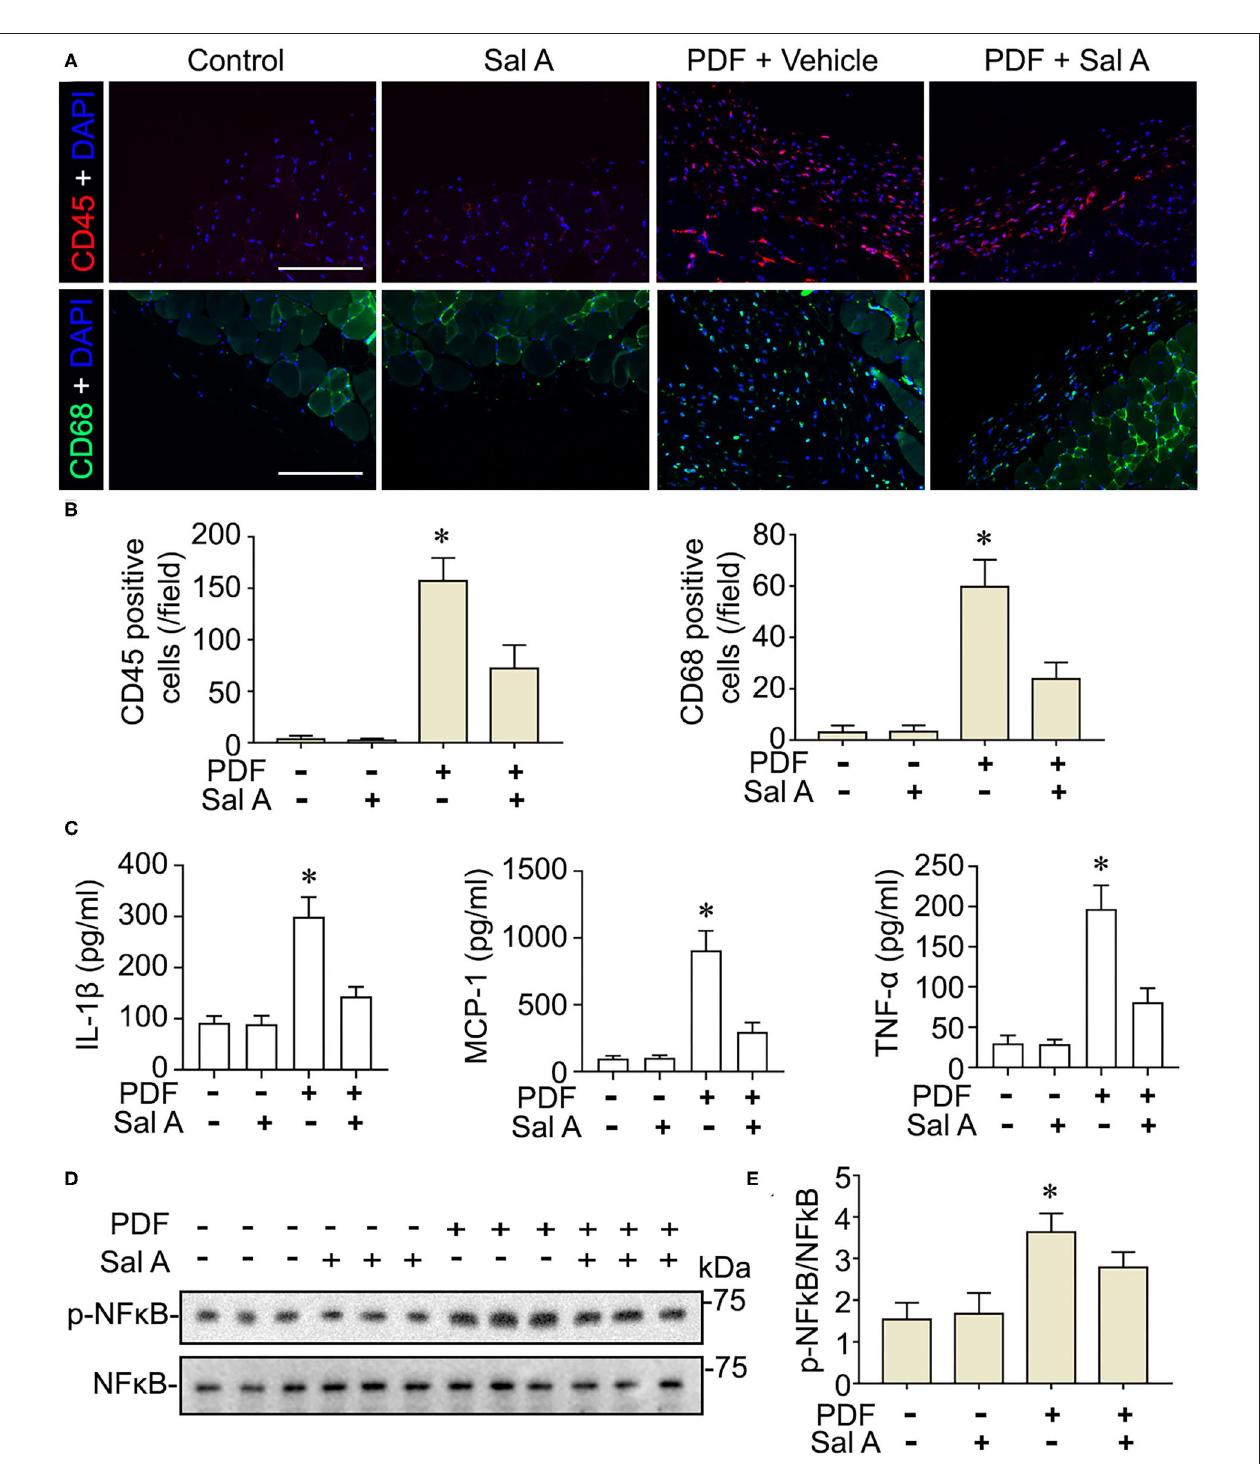
FIGURE 4 | Sal A treatment of murine models of peritoneal dialysis attenuates inflammation and NF κ B activation in peritoneum. (A) Mice were treated as elaborated in Figure 2 . The peritoneal tissues were collected on week 7 and subjected to immunofluoresence staining for CD45 or CD68 with nuclear counterstaining of DAPI. Scale bar = 200 µ m. (B) Absolute counting of CD45 or CD68 positive cells. Data were analyzed by one-way ANOVA followed by Tukey’s test. * P < 0.05 vs. other groups ( n = 6). (C) The expression levels of IL-1 β , MCP-1, and TNF- α ( n = 4). Data were analyzed by one-way ANOVA followed by Tukey’s test. * P < 0.05 vs. other groups. (D) Representative immunoblots showing immunoblot analysis of peritoneal tissues for indicated molecules. (E) Relative abundance of p-NF κ B p65, as normalized to that of NF κ B p65 based on densitometric analyses of immunoblots ( n = 6). Data were analyzed by one-way ANOVA followed by Tukey’s test. * P < 0.05 vs. other groups.